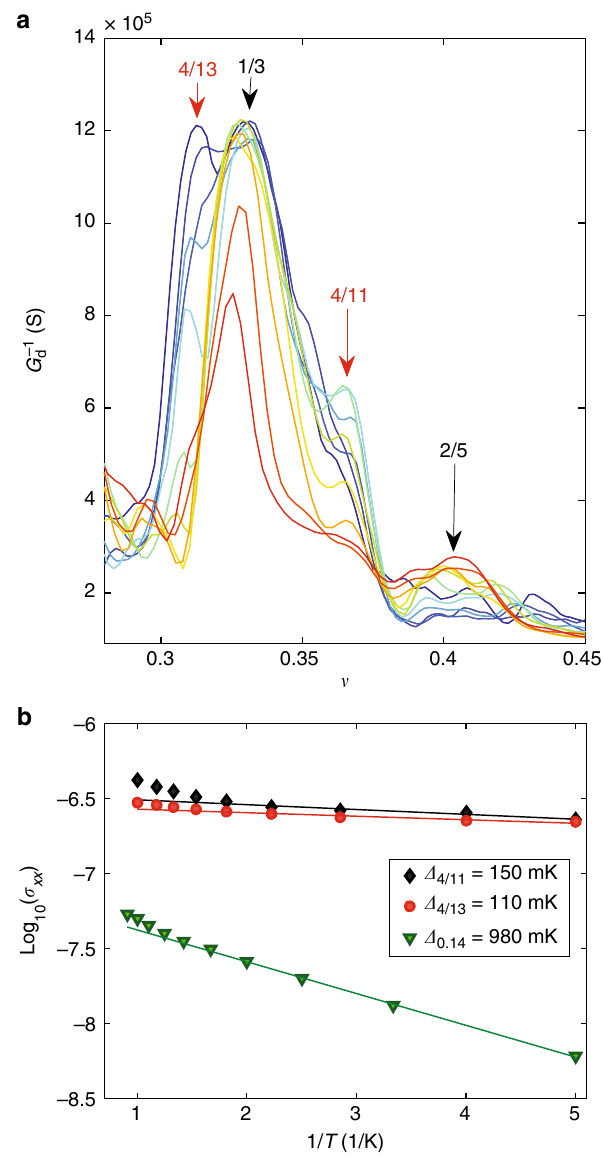
Fig. 3 Unconventional FQH states. a Inverse differential conductance through the Corbino disk measured at AC for sample EV2 at magnetic fi elds between 6 and 8.5 T, measured at 20 mK. The magnetic fi eld varies from 8.5 T (blue) to 6 T (red). The fractional states are identi fi ed by peaks at ν = nh / e B in inverse conductance traces which collapses on top of each other in G (cid:2) 1 vs. ν plot. Distinct states at ν = {4/13, 1/3, 4/11, 2/5} are identi fi ed d from measured traces. b The Arrhenius plot of DC conductivity σ xx at B = 7 T for fractional states at ν = 4/11 (black diamonds) and ν = 4/13 (red circles), contrasted to an activation measurement at ν = 0.14 (green inverted triangles) at B = 9 T. The straight lines represent Arrhenius fi ts that were used to extract the gaps of these states. The obtained gaps are also displayed as an